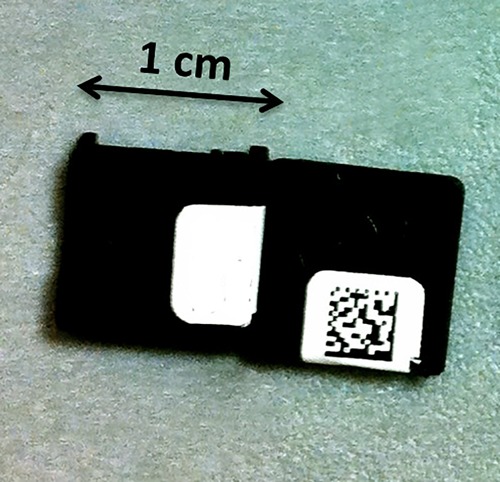
The nanoDot type of OSL using for measurement.